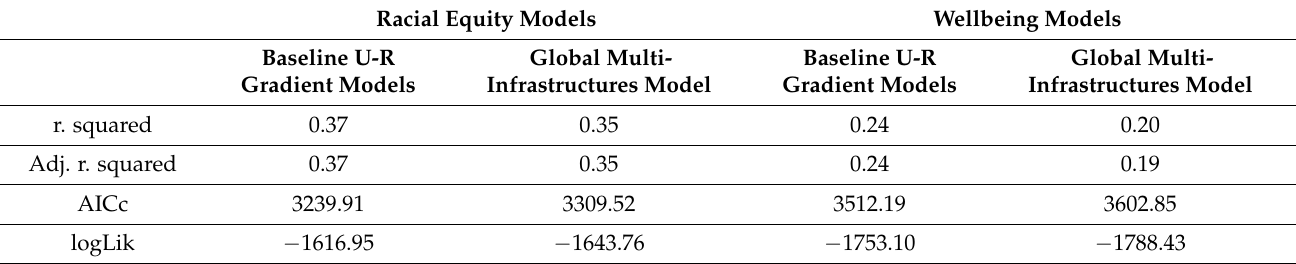
Table 2. Summary of